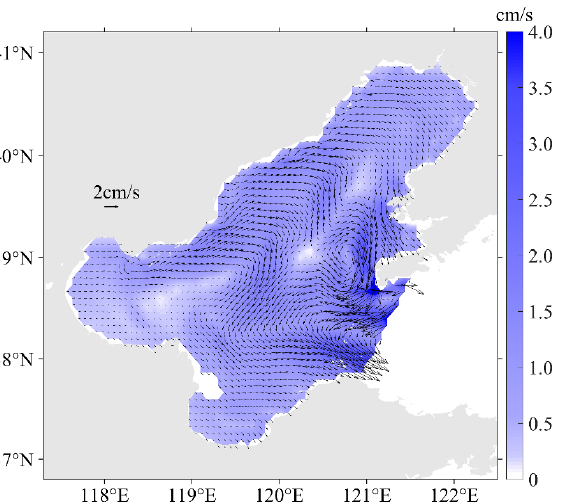
Figure 2. Monthly mean horizontal currents in the surface layer of the Bohai Sea in September.